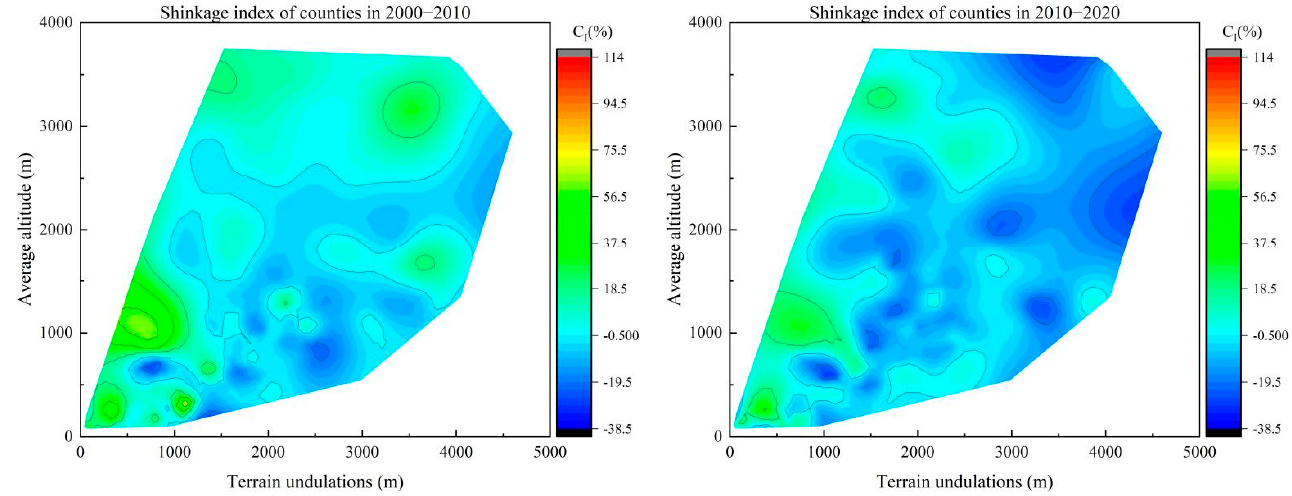
Figure 8. Contour map of county population shrinkage in the North − South Transitional Zone of China by time period.